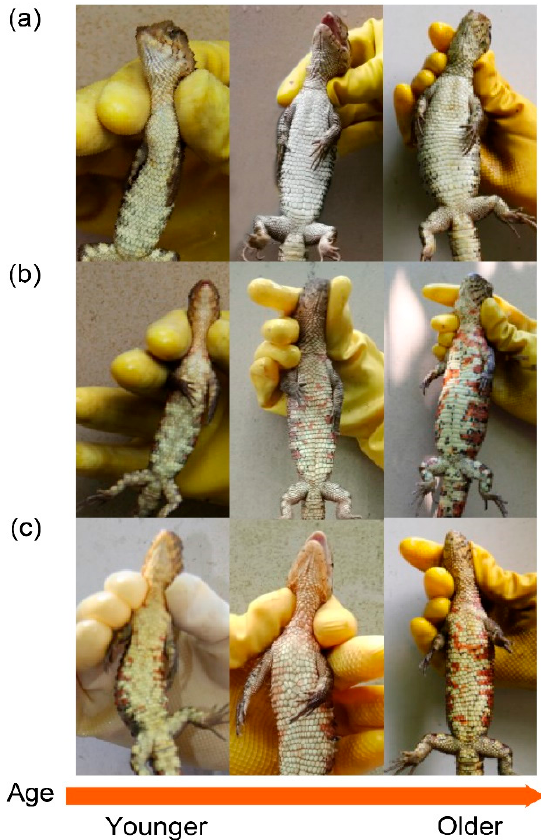
Figure 3. Ontogeny of colouration. ( a ) An individual born without red and which never developed red as it got older; ( b ) an individual born without red, but later developed red with age; ( c ) an individual born with red which became redder as it got older. The arrow at the bottom shows the direction of age change.